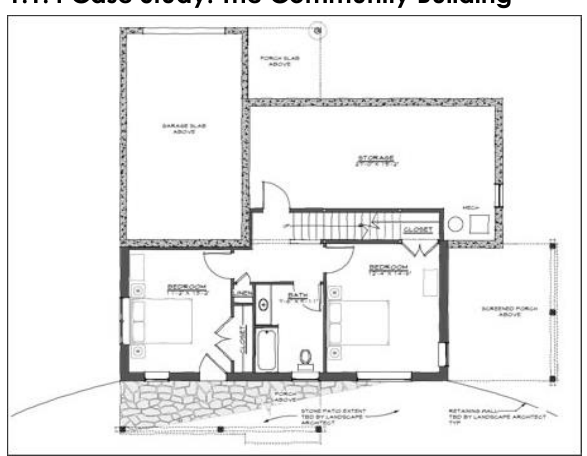
Figure 1. The Community Building, Ground